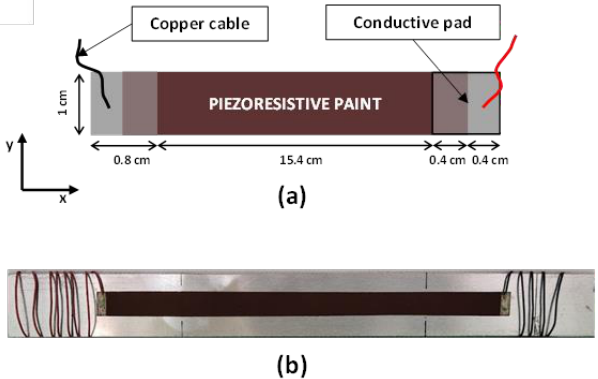
Figure 3. ( a ) Schematic representation of the piezoresistive sensor; ( b ) picture of the sensor realized on a mylar substrate glued onto an aluminum beam for the execution of the electromechanical tests.